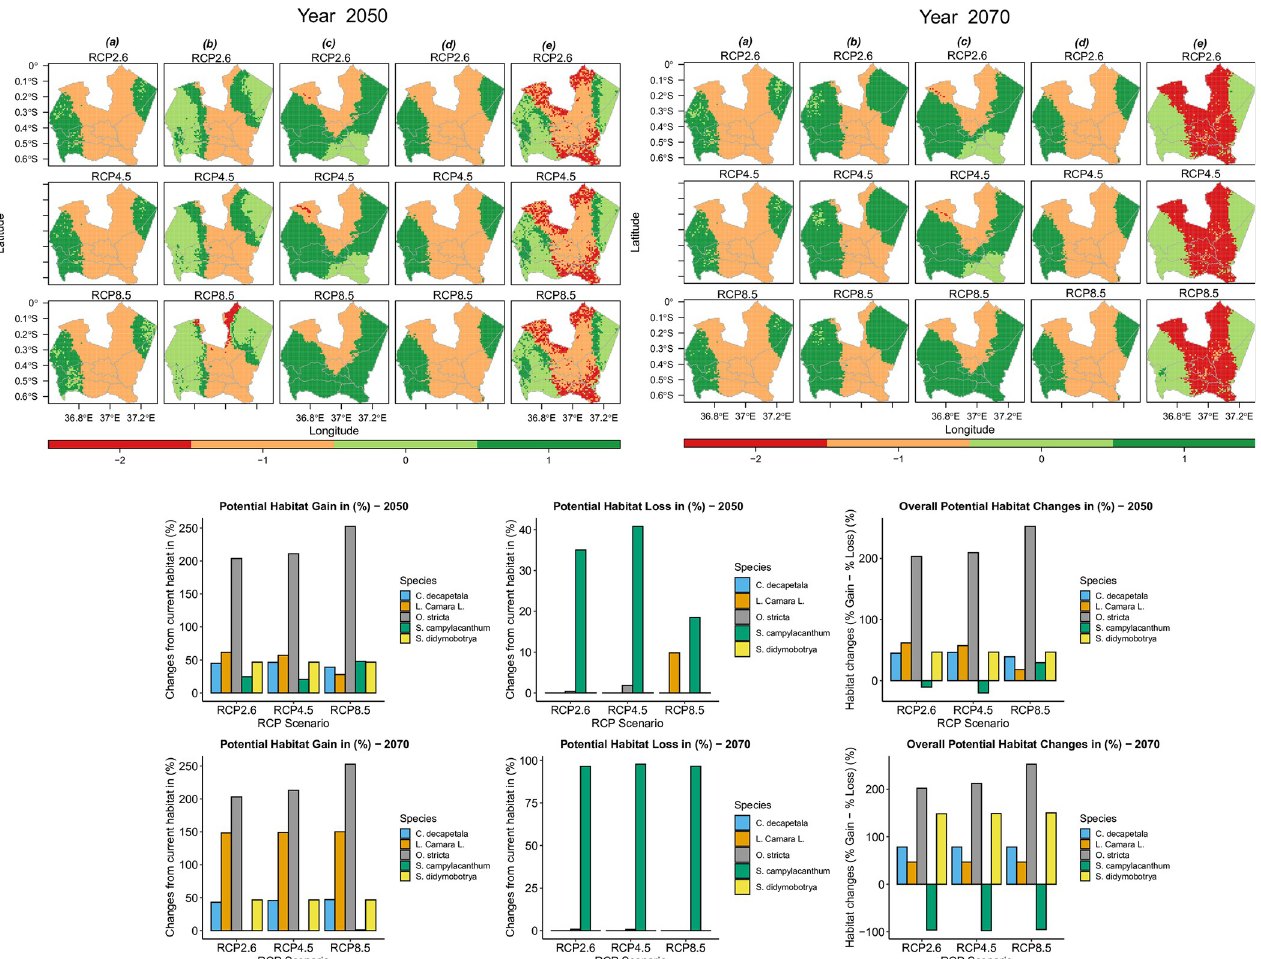
Fig 4. Predicted potential habitat gain, loss and overall habitat changes obtained from the predicted outputs from an average of bioclimatic variables of all GCM data. -2 represents habitat loss , -1 represents suitable and stable in future , 0 represents not suitable , 1 represents habitat gain . Species labels are as follows : (a) L . camara; (b) C . decapetala (Roth) Alston; (c) O . stricta; (d) S . didymobotrya; (e) S . campylacanthum Hochst . ex A . Rich .). Data Source: (Administrative Boundary Layer: GADM database (www.gadm.org) under CC BY 4.0 license